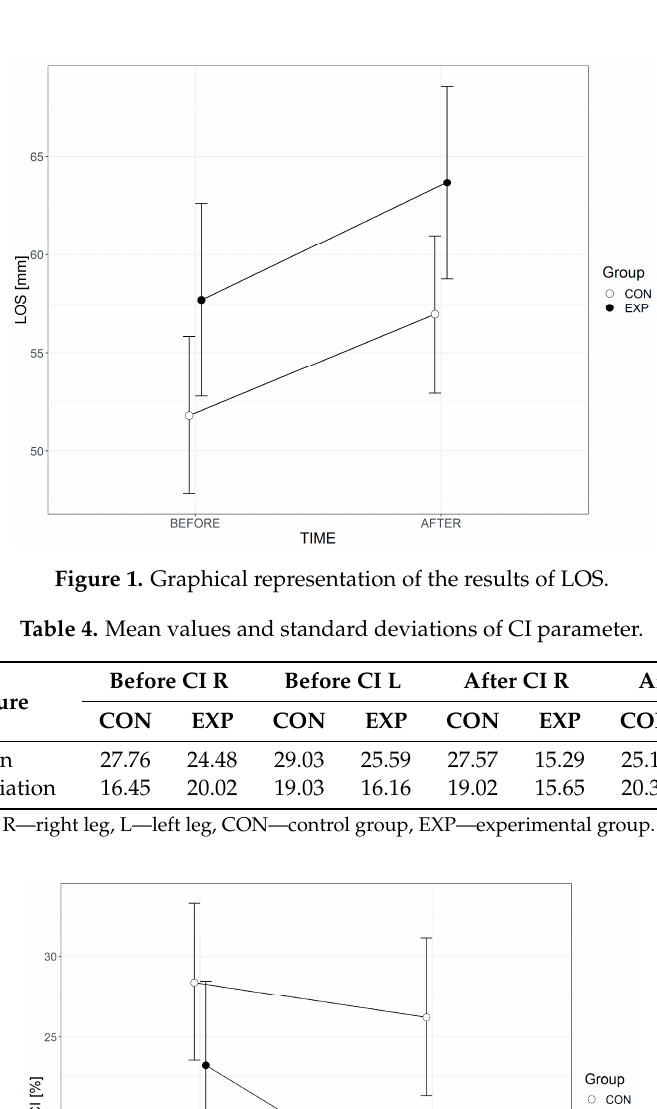
Figure 1. Graphical representation of the results of LOS.